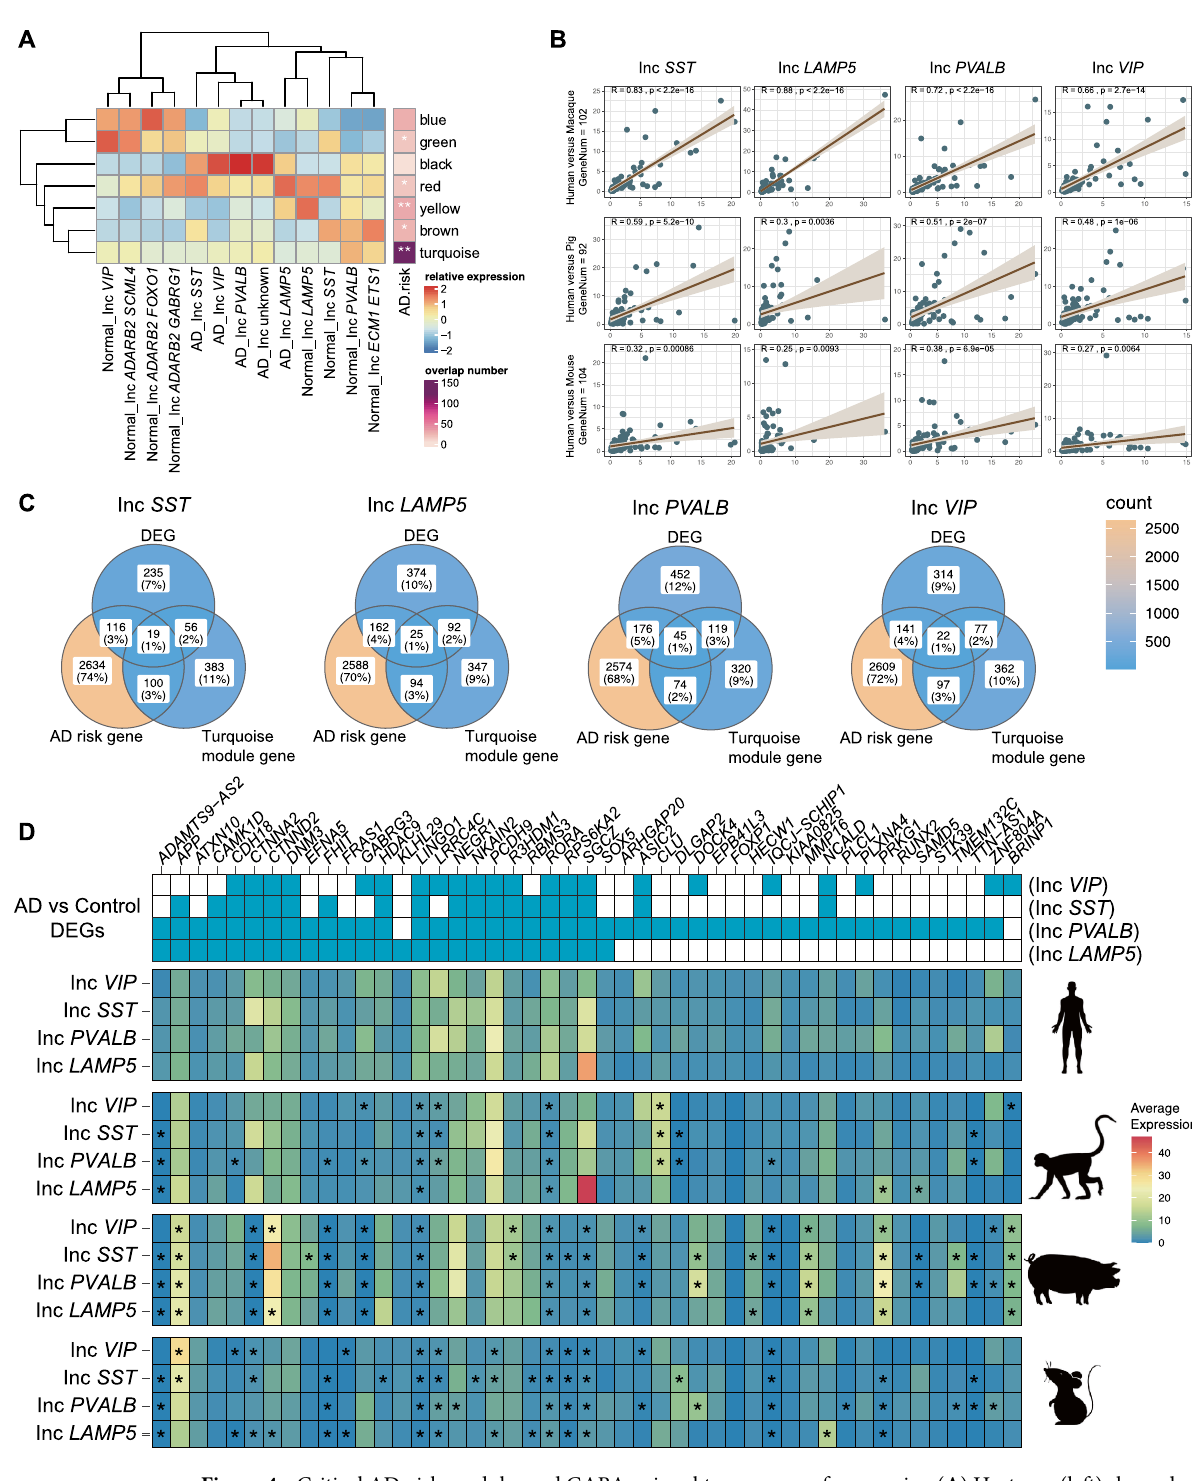
Figure 4. Critical AD-risk modules and GABAergic subtypes among four species. ( A ) Heatmap (left) showed relative expression of 7 WGCNA modules among different cell types. Each module expression was calculated as an average expression of all genes in the corresponding module and scaled by columns. Heatmap (right) showed the number of overlaps between module genes and AD high-risk genes, and the significance ( P value) of the hypergeometric distribution test identified the module in which AD risk genes were over-represented ( P value: 0.01–0.05, *; 0.001–0.01, **). ( B ) Spearman correlation of snRNA-seq expression of AD susceptibility genes showing the conservation of each cell type genes associated with AD between human and each of three species on four cell types. ( C ) Venn plots showing DEG overlaps in each cell type between AD and control, AD risk genes, and turquoise module genes. ( D ) The above heatmap displayed the DEGs in four GABAergic subtype neurons, in which blue represented significantly DEGs (adjusted P value < 0.05). Expression patterns of genes (columns) were associated with AD by cell type (rows) in four species. The degree of disease-associated gene enrichment in cell type was calculated by the Wilcoxon Rank Sum Test. * P <